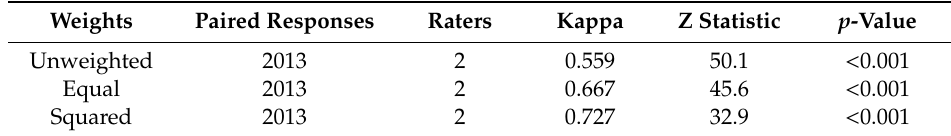
Table 4. Inter-rater reliability omnibus tests. Cohen’s Kappa scores matrix containing multiple individual items. The table shows Kappa scores using linear weighted Kappa only. Paired responses represent the number of paired responses from which the Kappa was calculated. They include questions × the number of horses (possible question pairs for comparison) minus “true” missing values. Supplementary File S2 contains the 215 question items in each matrix.